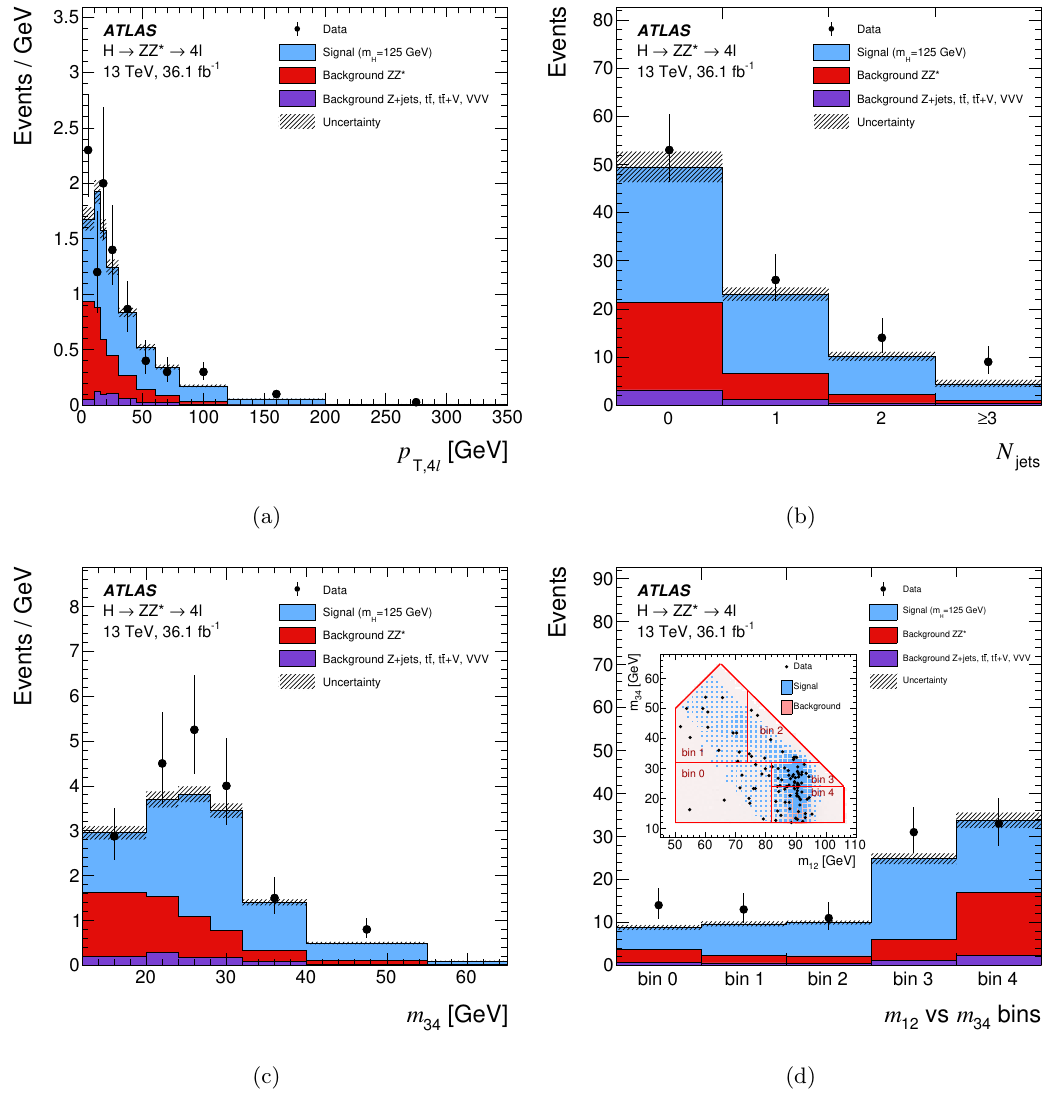
Figure 3. Measured data yields compared to SM Higgs boson signal and background processes for (a) the transverse momentum of the four leptons p T ; 4 ‘ , (b) the number of jets N jets , (c) the invariant mass of the subleading lepton pair m 34 , and (d) the invariant mass of the leading vs the subleading pair m 12 vs m 34 . Figure (d) also includes an illustration of the chosen bins, as well as the two-dimensional distributions of data and prediction. The error bars on the data points indicate the statistical uncertainty. The uncertainty in the prediction is shown by the dashed